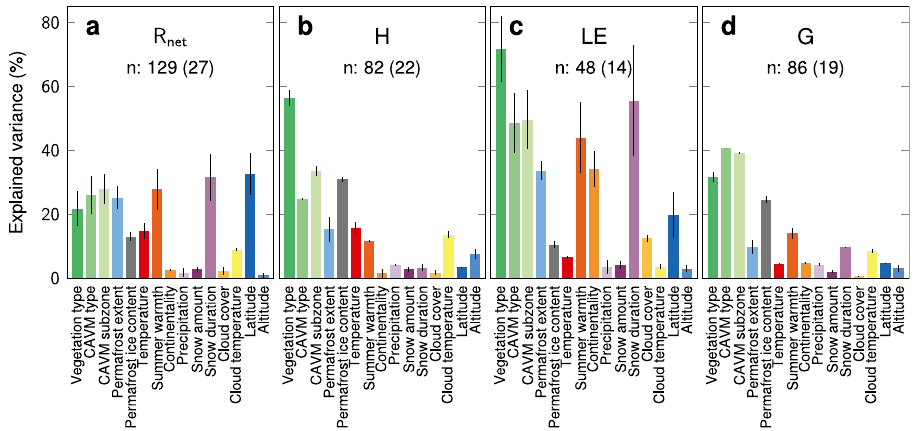
Fig. 1| Relativeimportanceof15driversofthesurfaceenergy budget(SEB)for averagesummersurfaceenergy fl uxmagnitudesatnon-glaciersites. Barsshow the mean (bar height) and range (lines for each bar) of explained variance (%) averaged across all possible models with 2 predictors for each SEB-driver and corresponding summer magnitudes of surface energy fl uxes (Wm − 2 ): ( a ) R net : net radiation, ( b ) H: sensible heat fl ux, ( c ) LE: latent heat fl ux, ( d ) G: ground heat fl ux. SEB-drivers:Vegetationtype(darkgreen):local-scale,insituvegetationtype;CAVM type (green): landscape-scale, dominant vegetation type (surrounding area with radius of 500m); CAVM subzone (light green): bioclimatic subzone; Permafrost extent (light blue): permafrost spatial extent; Permafrost ice content (grey): per- mafrost ground ice content; Temperature (red): mean annual air temperature; Summer warmth (dark orange): summer warmth index; Continentality (orange):